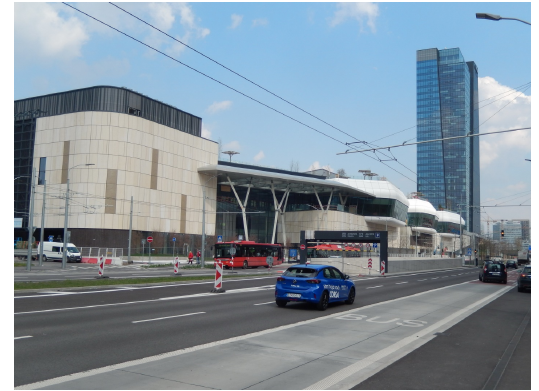
Figure 3. View of the completed area of the bus